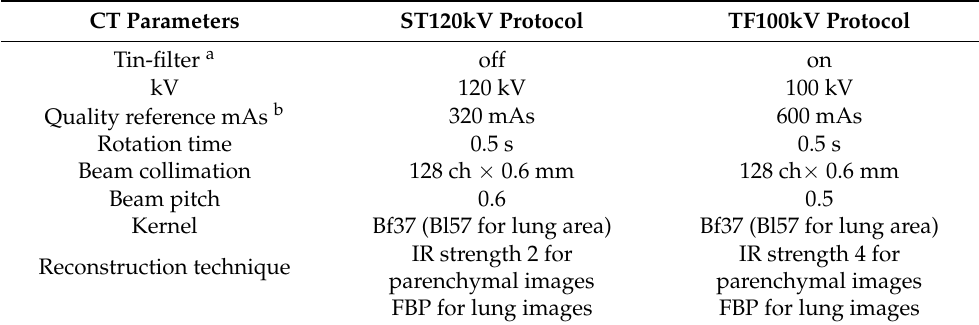
Table 1. CT acquisition scanning parameters for both standard and spectral filtration